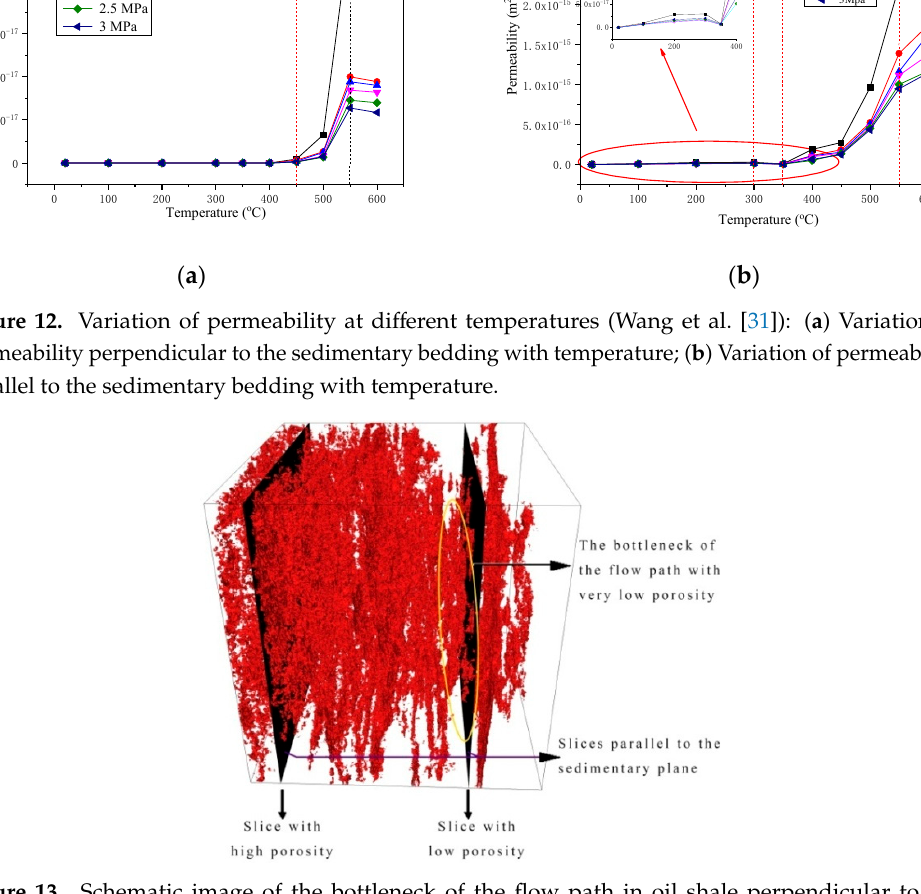
Figure 13. Schematic image of the bottleneck of the flow path in oil shale perpendicular to the sedimentary bedding direction.